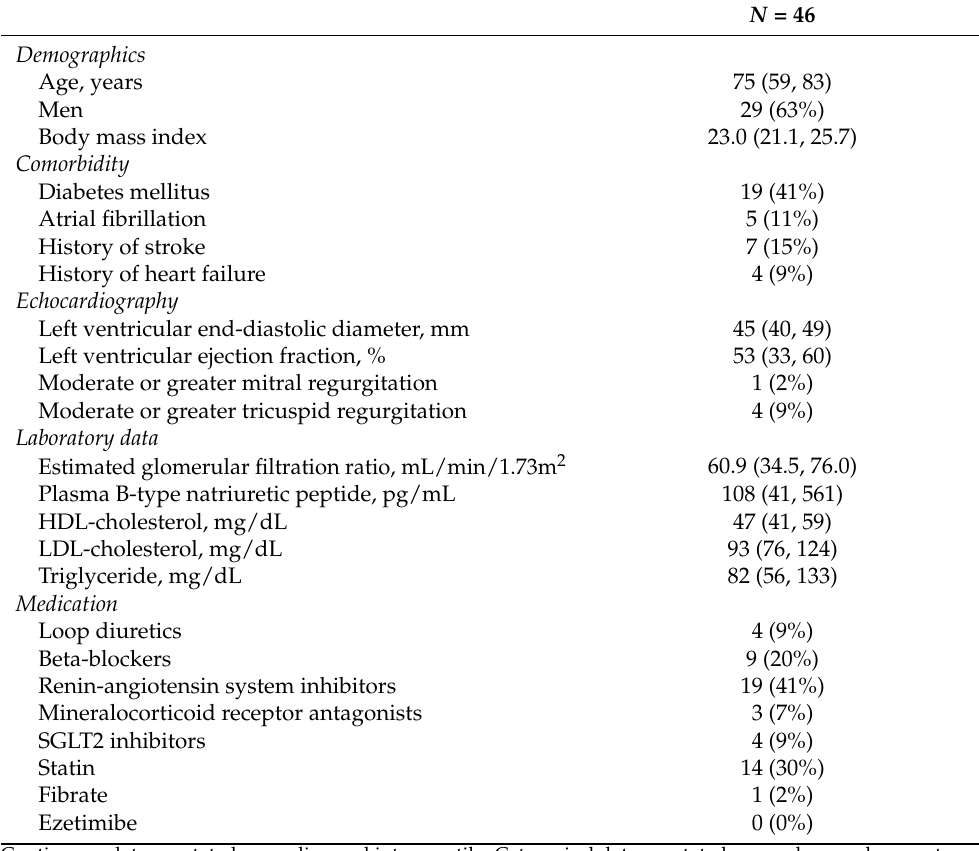
Table 1. Baseline characteristics on